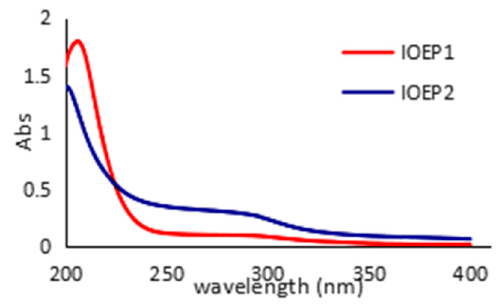
Figure 3. UV absorption spectra of IOEP1 and IOEP2.